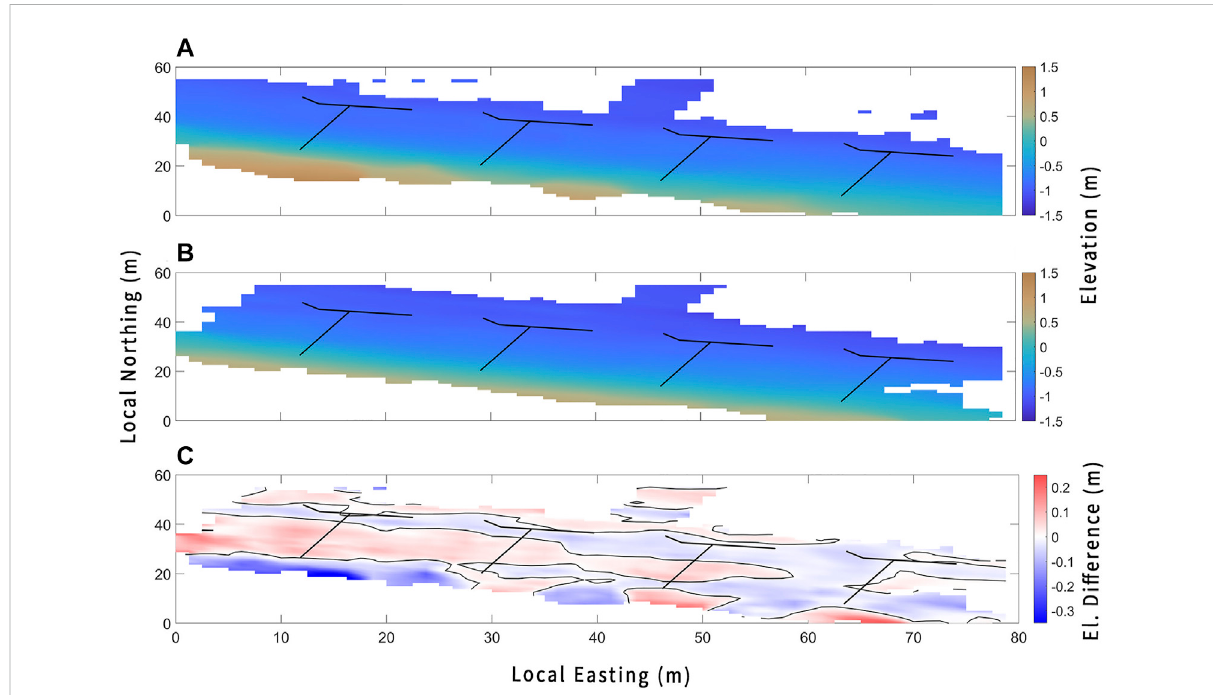
FIGURE 6 Elevation surveystaken in (A) Mayand (B) Septemberand (C) the difference between thetwo surveys in (A) and (B) .THGs are delimited byblack lines. In (C) the zero-contour line is shown in